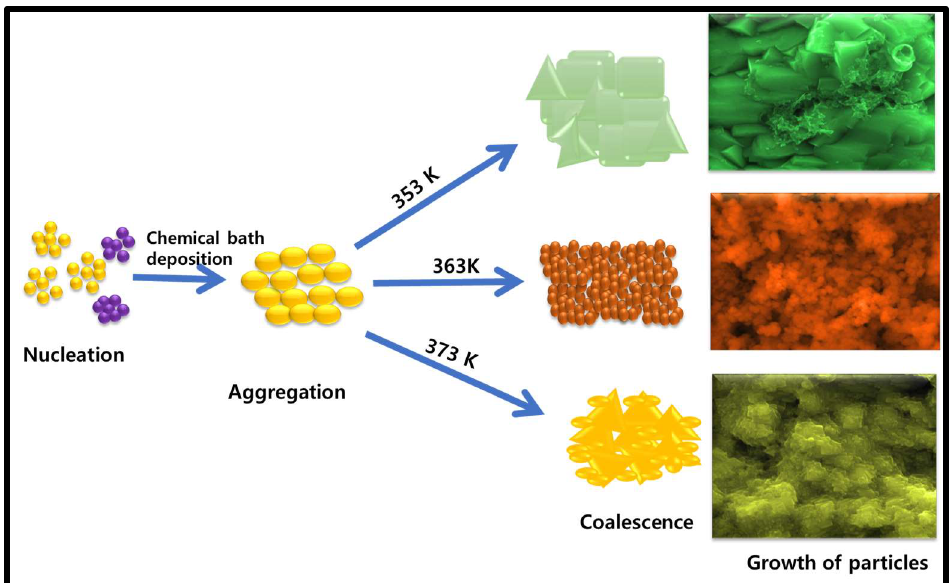
Scheme 1. Schematic of synthesis of α-Fe 2 O 3